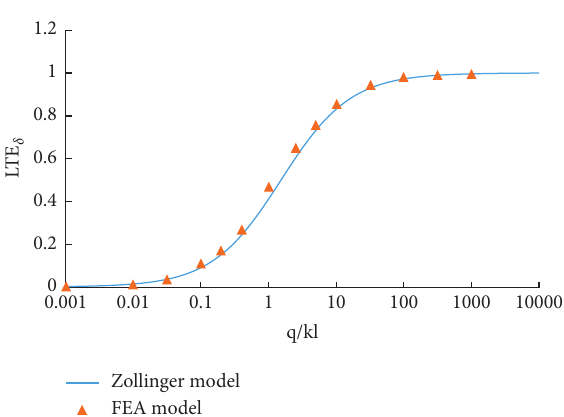
and LTE in intact pavement. δ σ